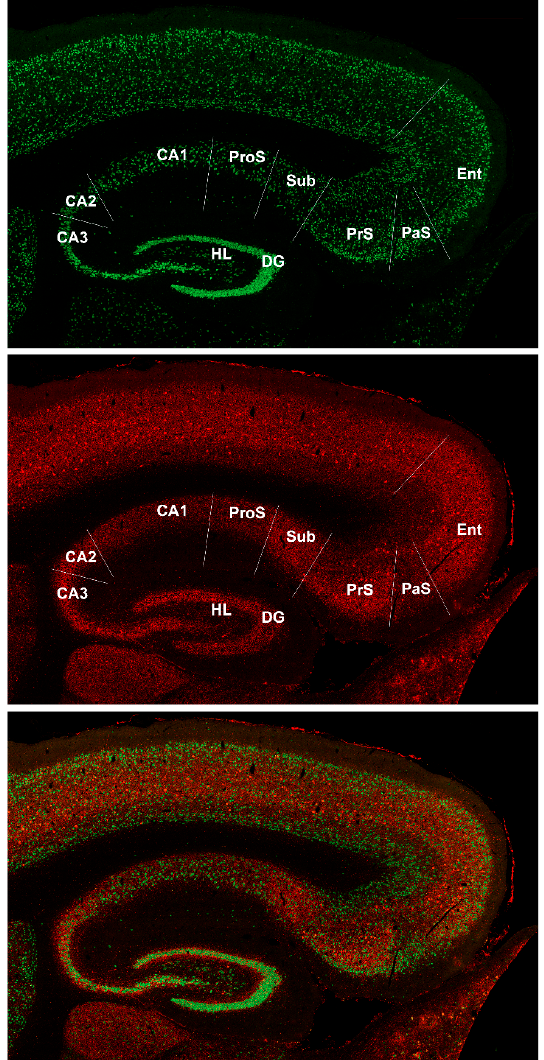
Figure 2. Hippocampal formation in the brain of Carollia perspicillata labeled with NeuN and par- valbumin. Tiled confocal 63 × sagittal composite section of Carollia brain labeled with NeuN (top panel—green channel) and parvalbumin (middle panel—red channel) to show subregional bound- aries in greater detail. A merged image is shown in the bottom panel. The subregional boundaries are described in the Results and are drawn on the figure as white lines. The sagittal plane of this section was determined to be 2.45 mm from the lateral edge and 2.07 mm from the midline. Additional